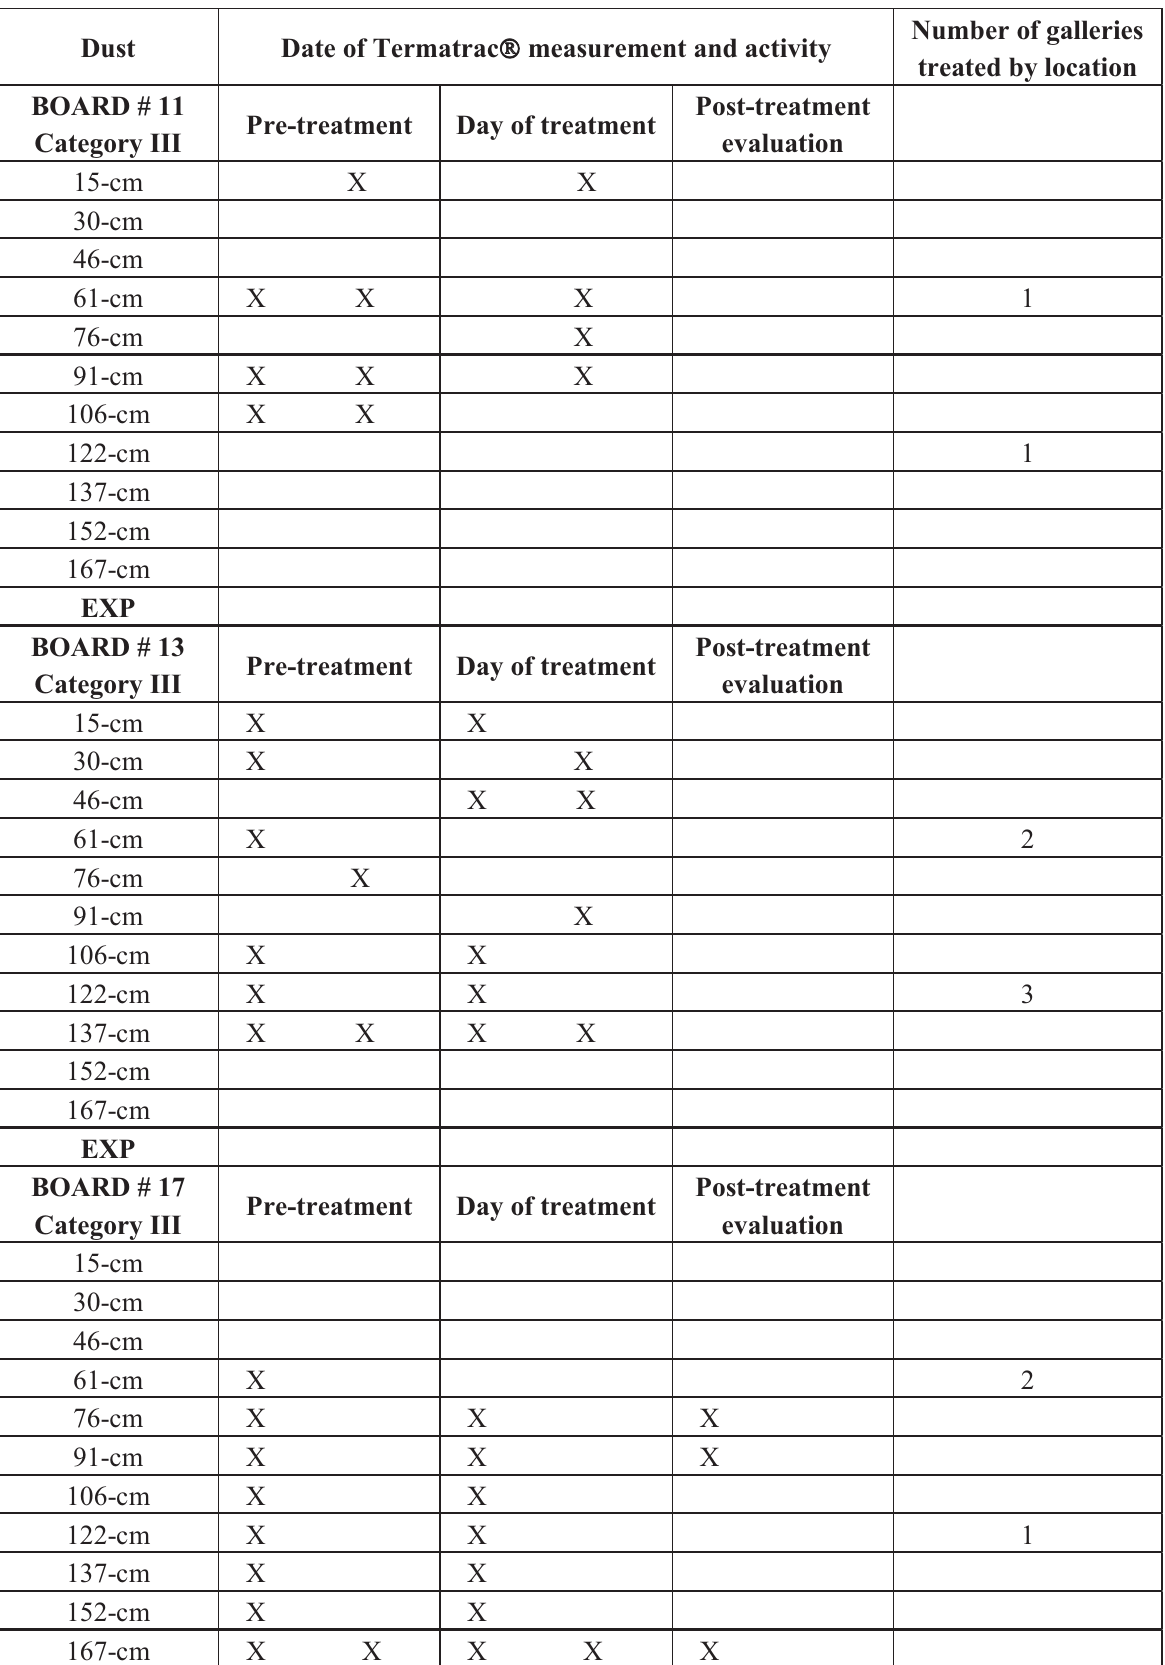
Date of Termatrac (cid:2)(cid:2) measurement and